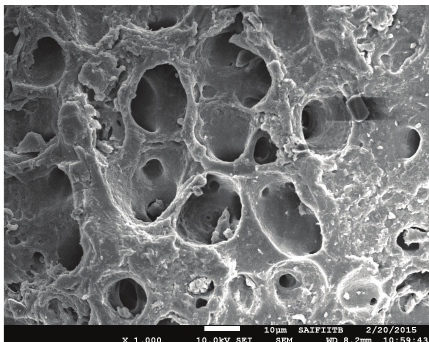
Figure 5: EDS spectra of CCRWSD.